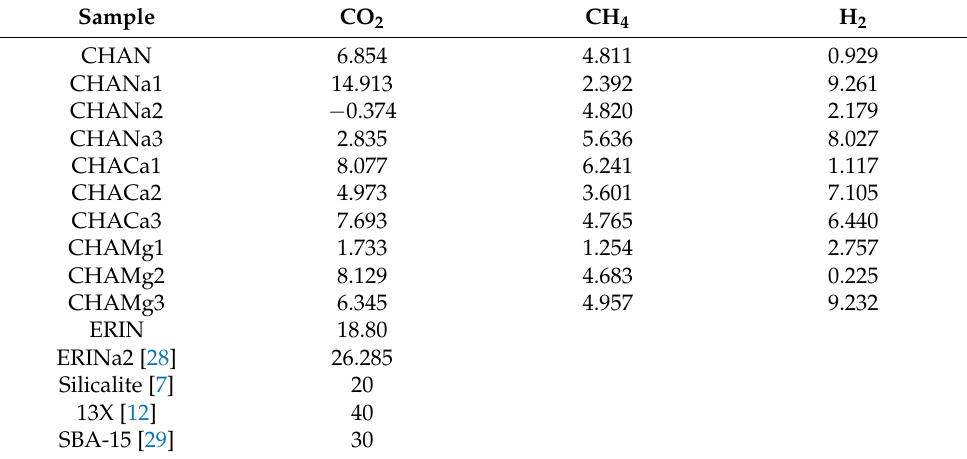
Table 6. The isosteric enthalpy (kJ mol − 1 ) of adsorption of CH 4 , H 2 , and CO 2 .